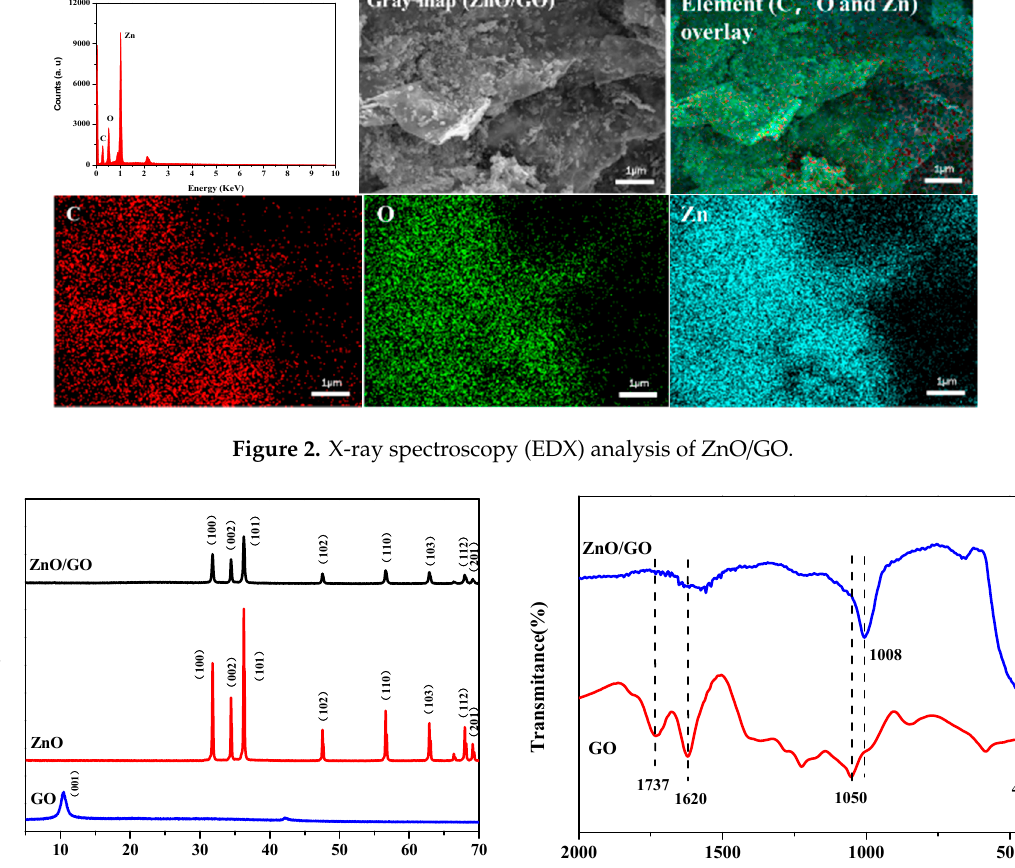
Figure 1. FESEM micrographs of ( a ) ZnO/GO-5wt%, ( b ) ZnO/GO-10wt%, ( c ) ZnO/GO-15wt%.